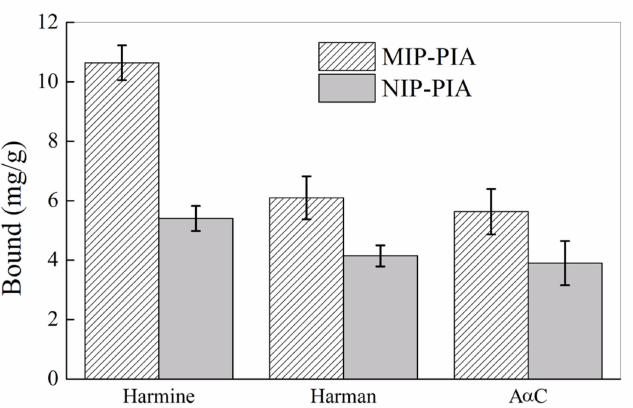
Figure 11. Equilibrium binding of MIP-PIA and NIP-PIA nanospheres toward harmine and its structural analogues (20 mg/L) in